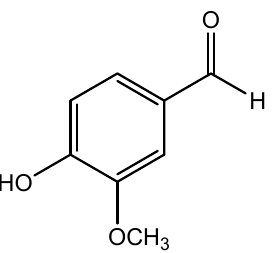
Figure 1. Chemical structure of 4-hydroxy-3-methoxybenzaldehyde, vanillin. Natural vanillin is isolated from plants (i.e., vanilla beans) as a result of long and expensive processes, whereas artificial vanillin is produced using cheap precursors [27].